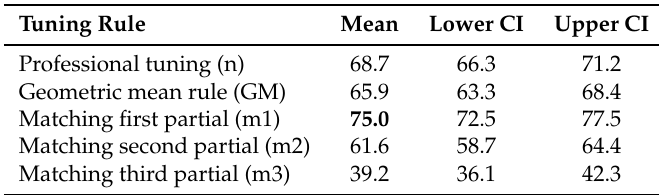
Table 1. Table showing the results of the listening test. The values of the mean and 95% confidence interval (CI) are given for each tuning rule. The best mean result is